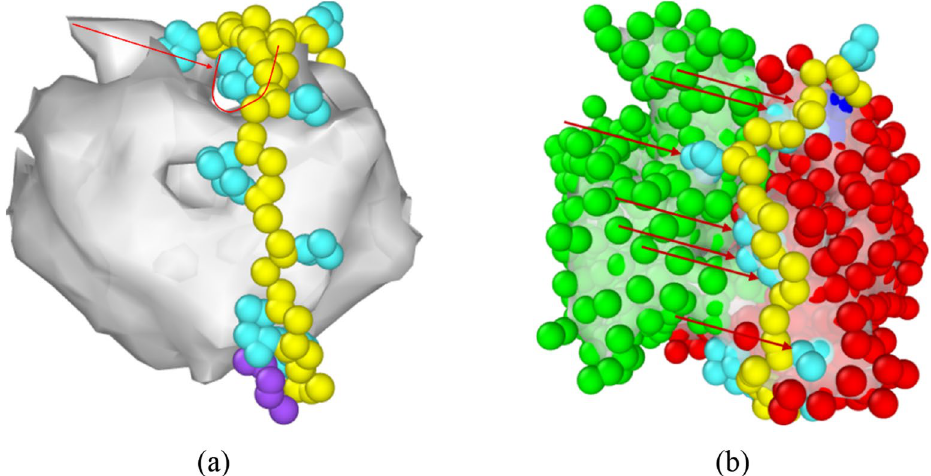
Figure 8. ( a ) The surface mesh of EpCAM with Apt EpA beads for CG_case1. The arrow and the U-shape symbol demonstrate the pocket space formed by the EpCAM dimer; ( b ) the EpCAM surface mesh, EpCAM beads, and Apt EpA beads for CG_case1. The arrows indicate the Apt EpA fragment (from base 3 to base 9) within the EpCAM pocket. The Apt EpA backbone and nucleobase are shown in yellow and cyan, while the 5 ′ and 3 ′ beads are colored in dark blue and purple. The two sides of the EpCAM dimer are shown with green and red. For clarity, all water beads, antifreeze, and ionic Na + are hidden.